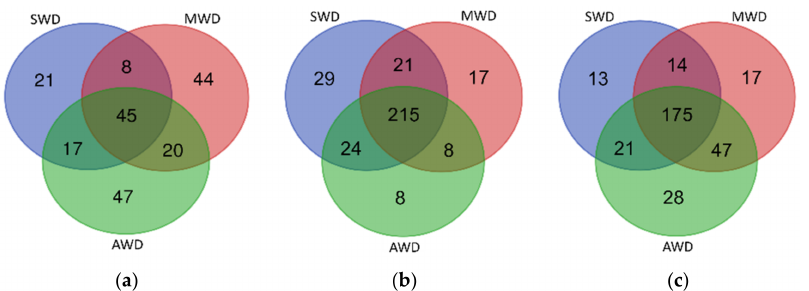
Figure 8. Venn diagram illustrating the overlap of the number of OTUs identified in the fungal microbiota among irrigation regimes (SWD: severe water deficit, MWD: moderate water deficit and AWD: absence of water deficit) in the ( a ) root, ( b ) rhizosphere, and ( c ) bulk